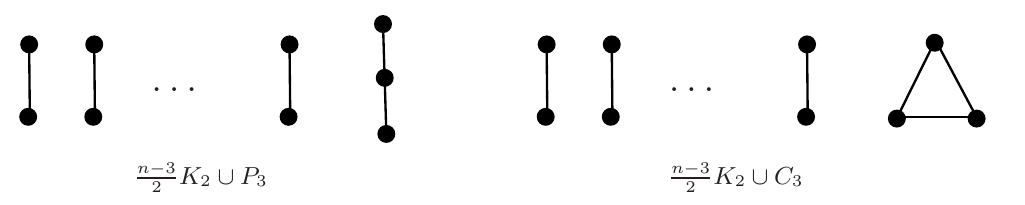
Figure 4: The maximal graphs in Theorem 4.3.